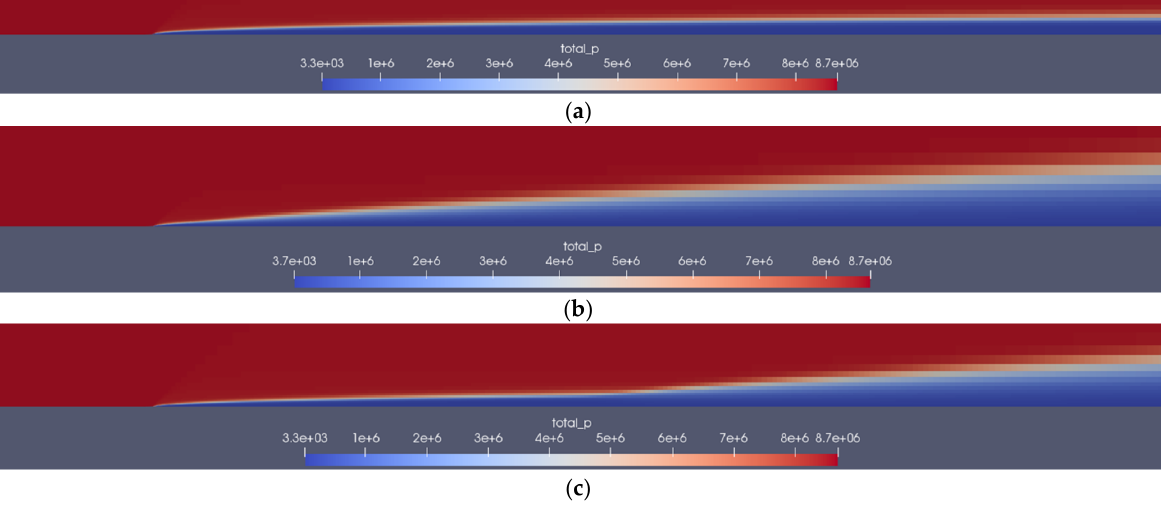
Figure A7. Total enthalpy of s00: ( a ) laminar model; ( b ) SA model; ( c ) SA-BCM model.